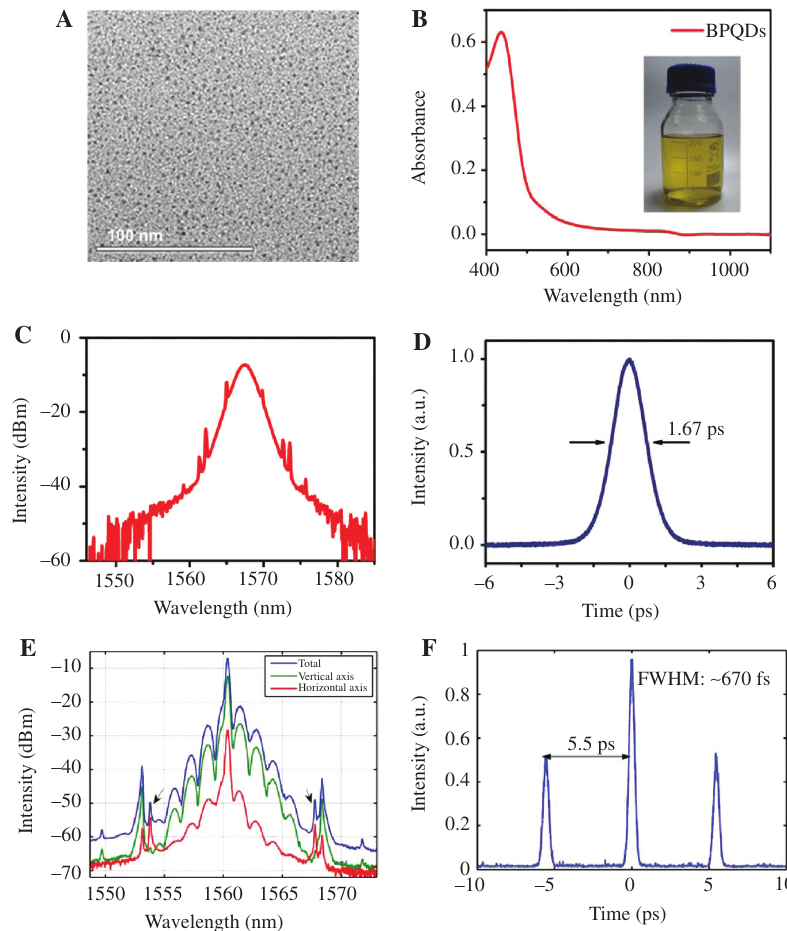
Figure 5: Mode-locked results enabled by BP-based SAs. (A) TEM image and (B) absorption trace (inset: NMP solution) of BPQDs, (C) spectrum, and (D) autocorrelation trace of mode-locked fiber lasers based on BPQDs. (E) Spectra and (F) autocorrelation trace of vector soliton fiber laser mode-locked by BP. (A)–(D) are reproduced with permission from Ref. [198]. Copyright 2016 Wiley-VCH Publishing. (E) and (F) are reproduced with permission from Ref. [145]. Copyright